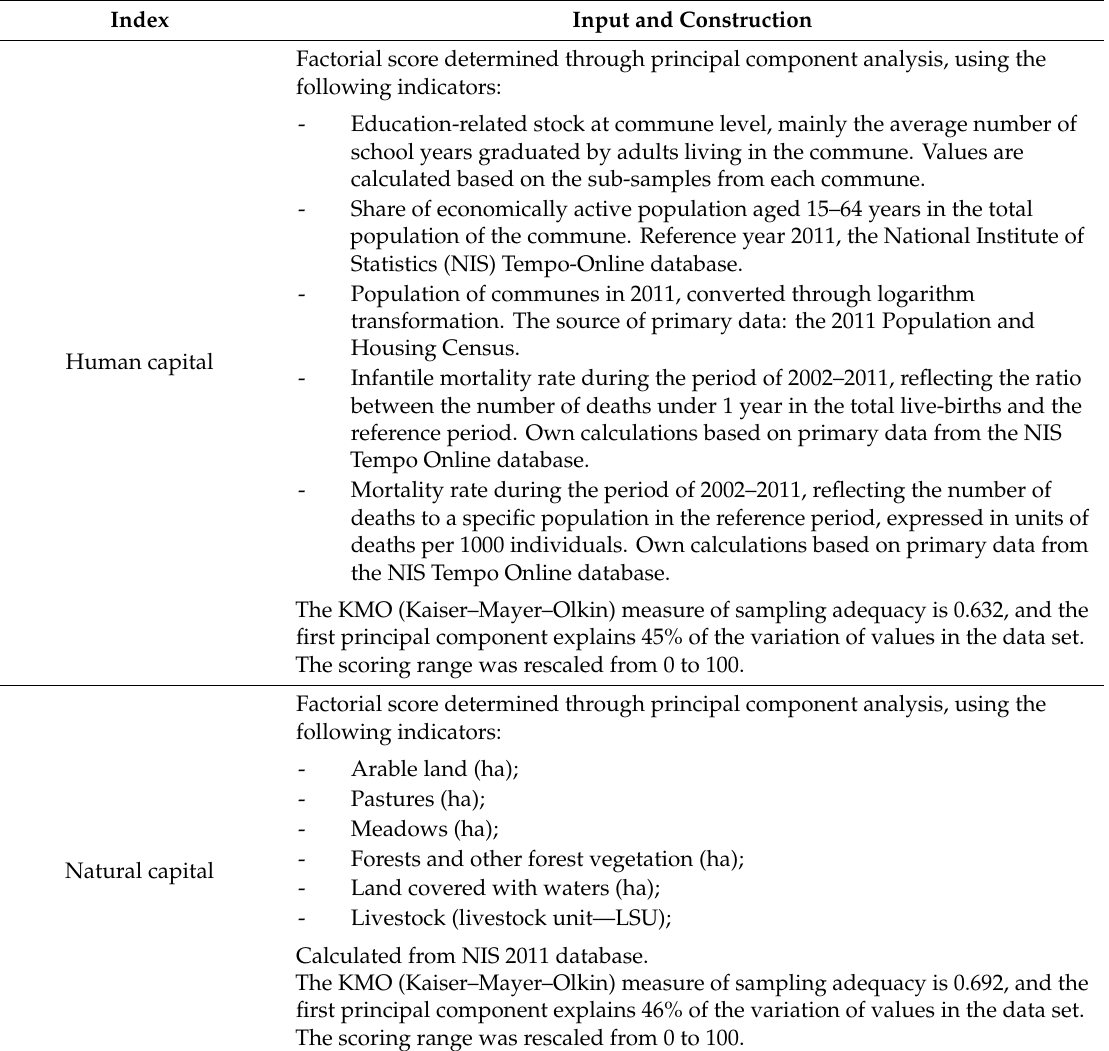
Table 1. Metadata on indices related to the community